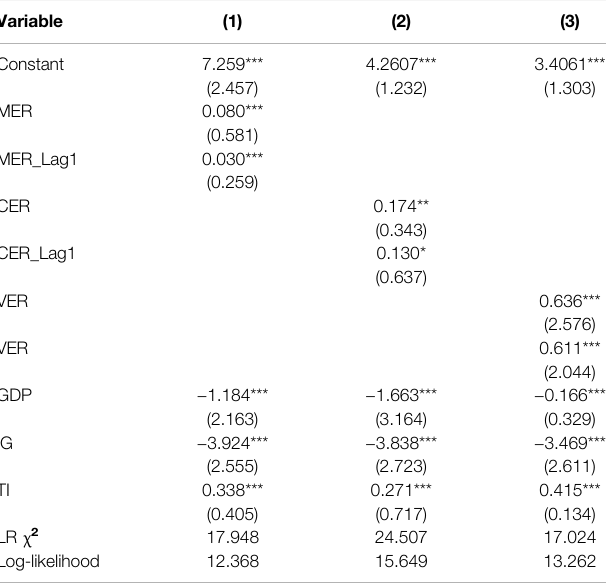
TABLE 7 | Results of regression analysis.